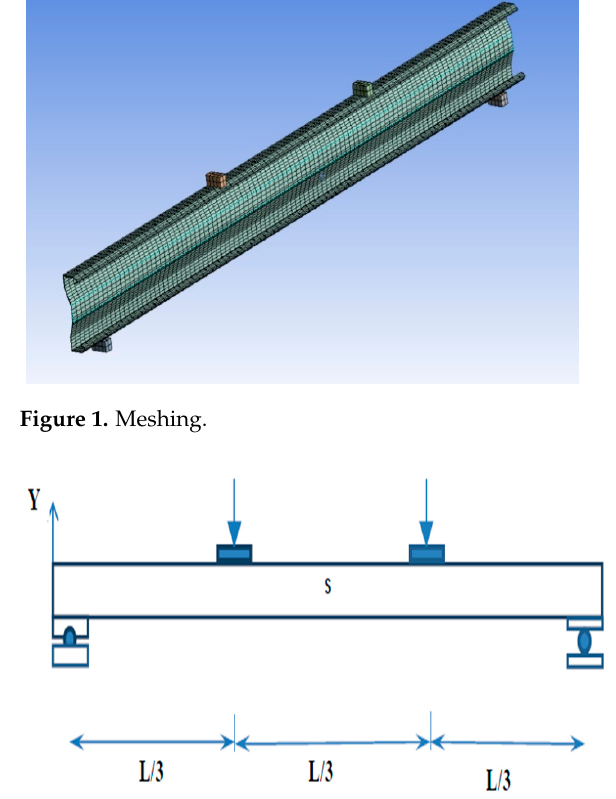
Figure 2. Physical model of the test setup.